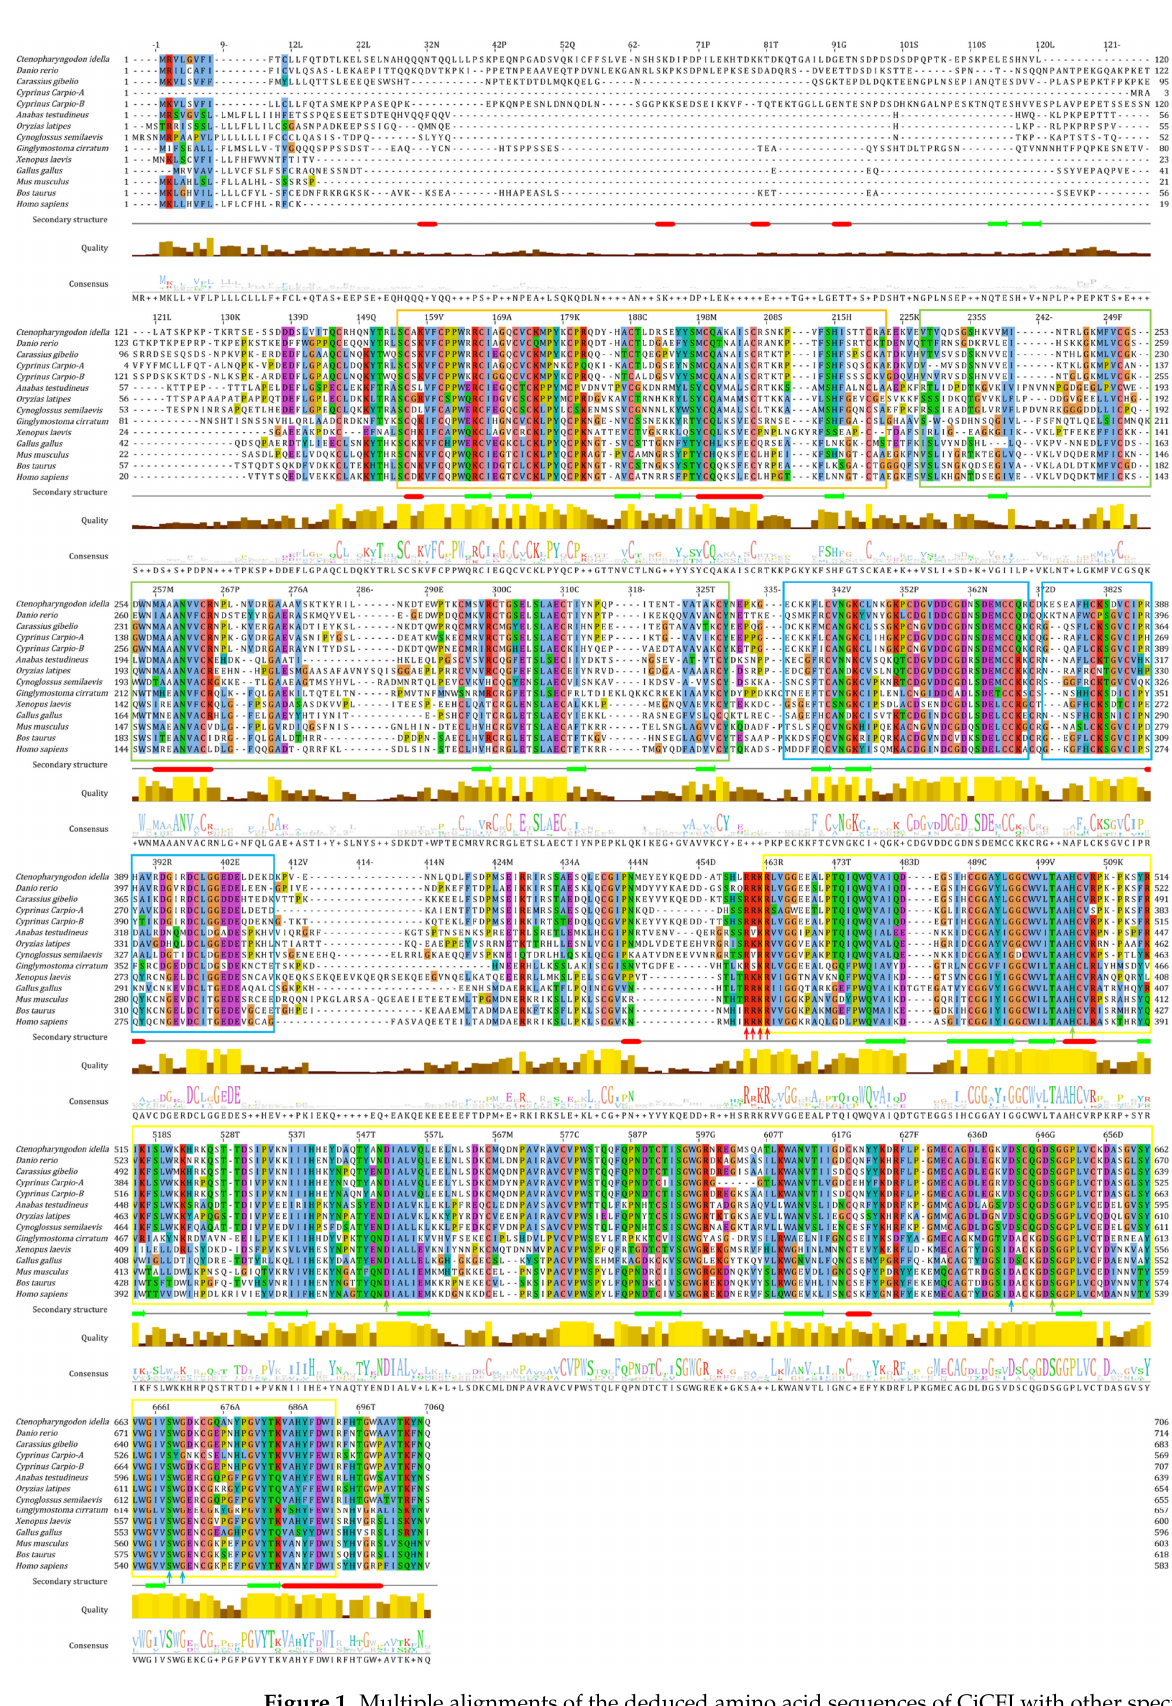
Figure 1. Multiple alignments of the deduced amino acid sequences of CiCFI with other species. The FIMAC, SR, LDLa1, LDLa2 and Tryp_SPc domains are marked by an orange box, green box, blue box, and yellow box, respectively. The cleavage site between a heavy chain and a light chain, the active site forming a catalytic triad, and the conserved substrate binding site are marked by red